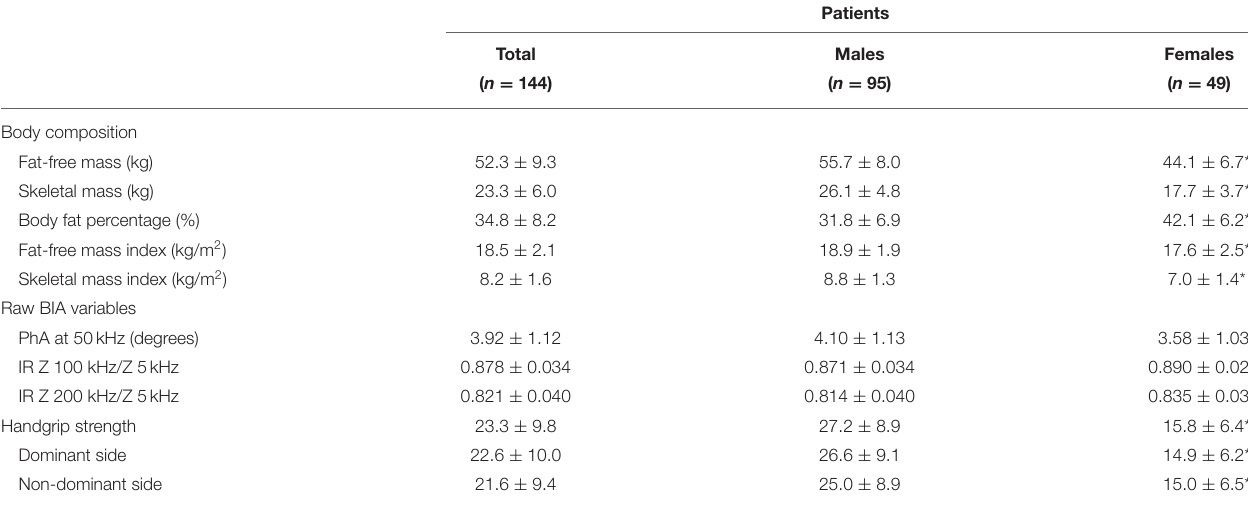
TABLE 2 | Body composition and handgrip strength in post-acute COVID-19